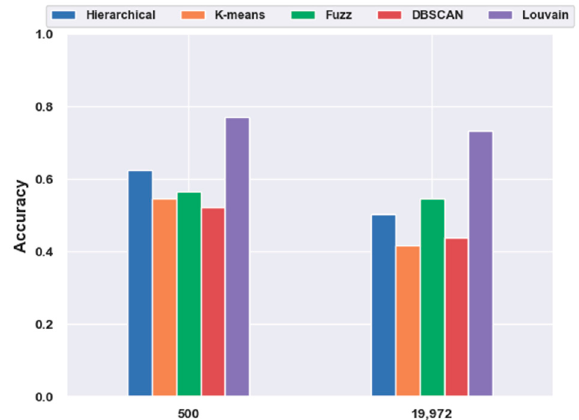
Figure 5. Comparison of the five clustering models with NFE on the mouse cortex data. The results of 19,972 genes are from the original data without dimensionality reduction. The results of 500 genes are from the mouse cortex data of 500 genes with feature selection.